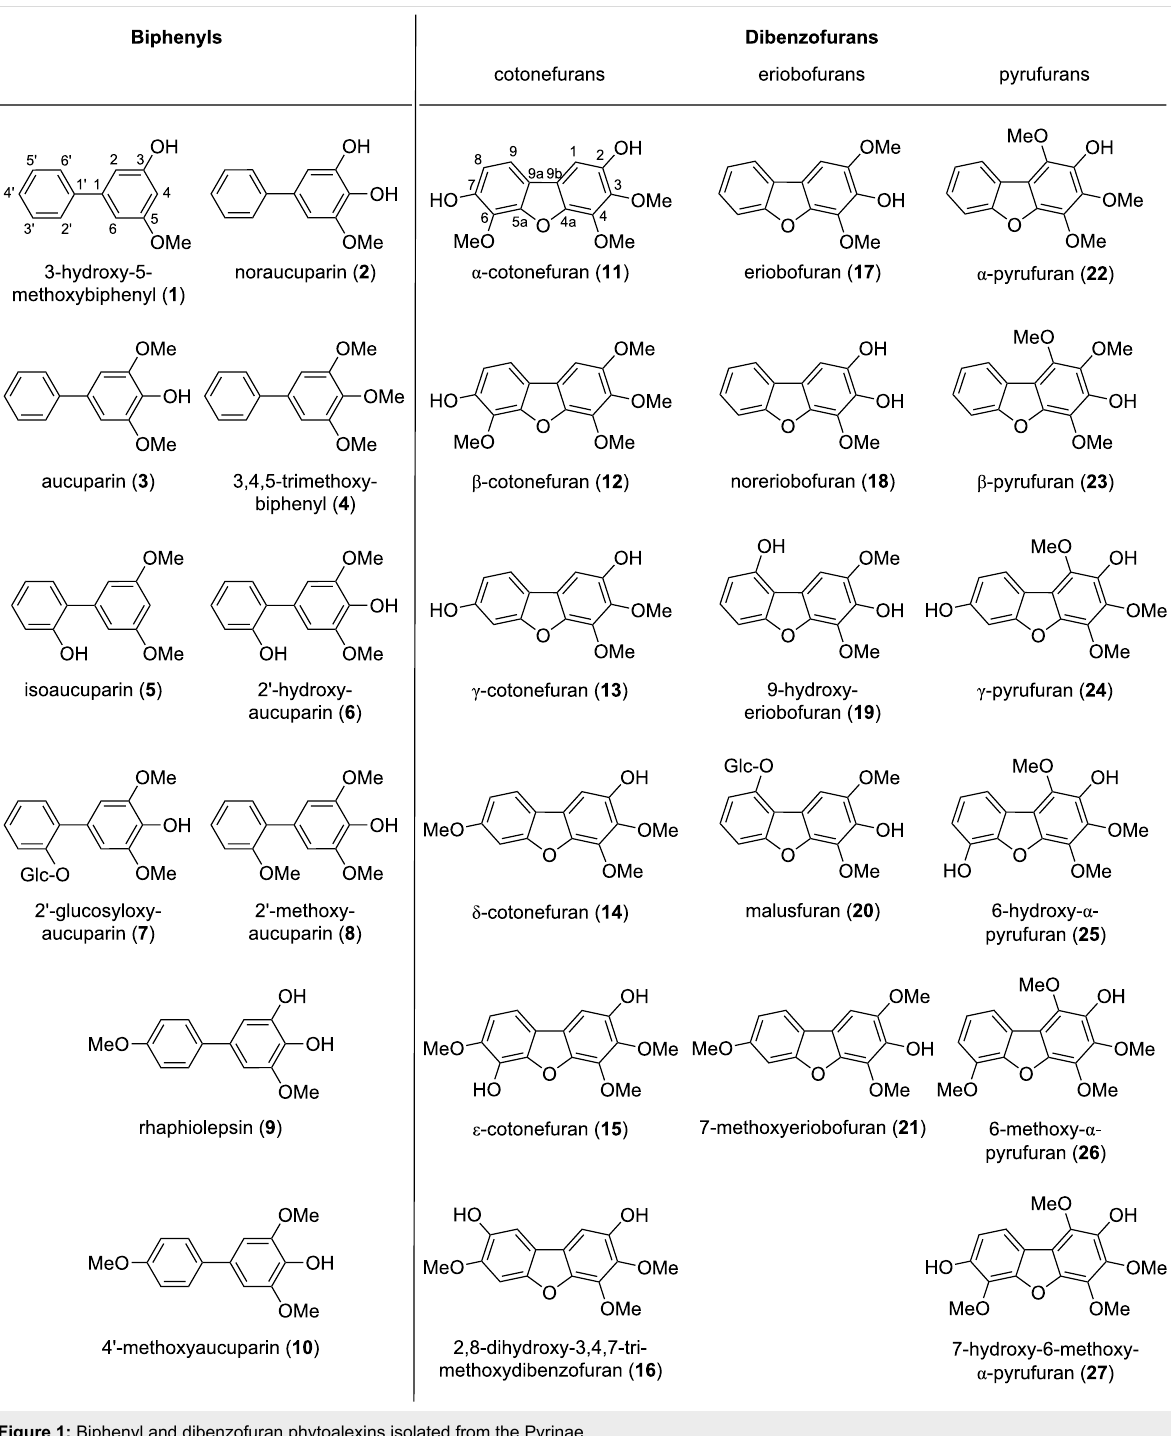
Figure 1: Biphenyl and dibenzofuran phytoalexins isolated from the Pyrinae.